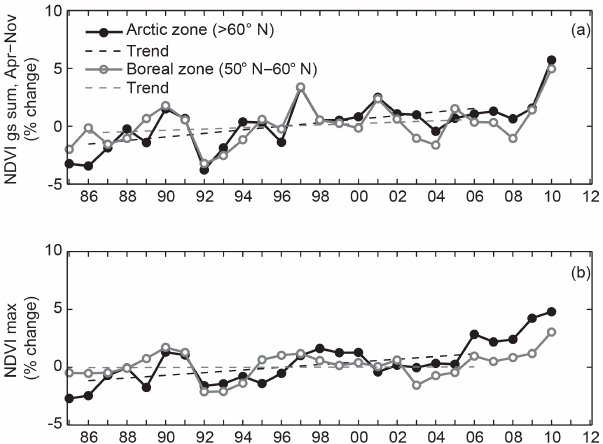
Figure 10. Time series of NDVI trends averaged for the analysis regions in this study. (a) Growing season (April–October) mean and (b) annual maximum, usually in July. Black is for the arctic zone and grey is for the boreal